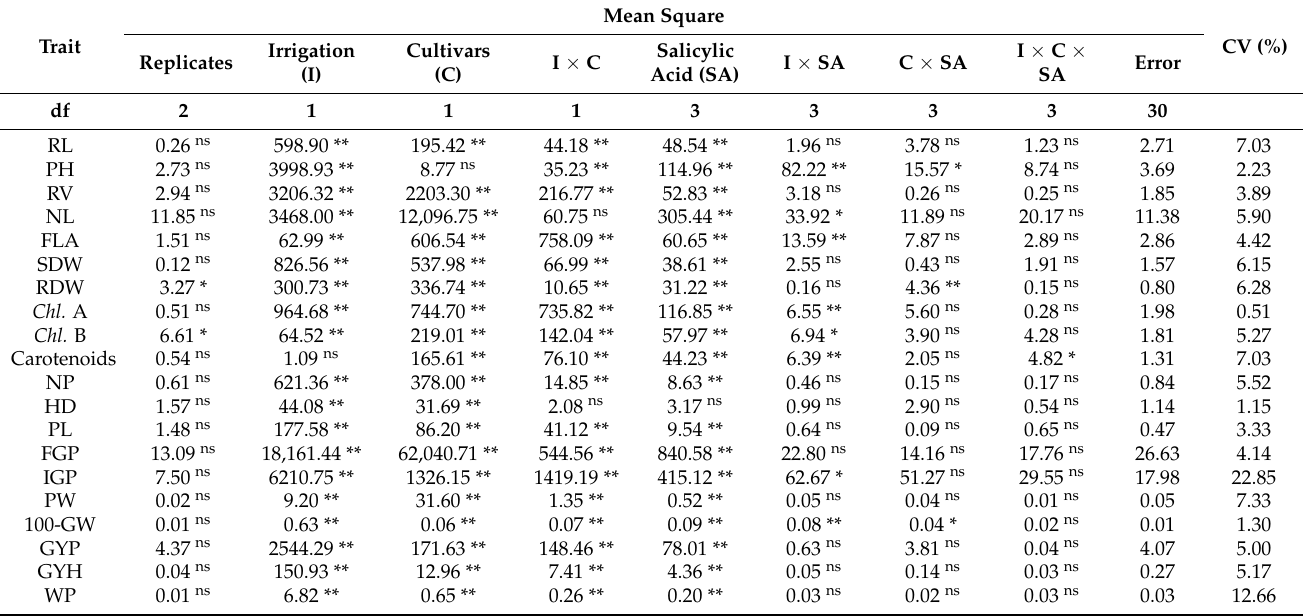
Table 4. Combined analysis of variance for the various quantitative traits of two rice cultivars and different salicylic acid under normal and drought stress